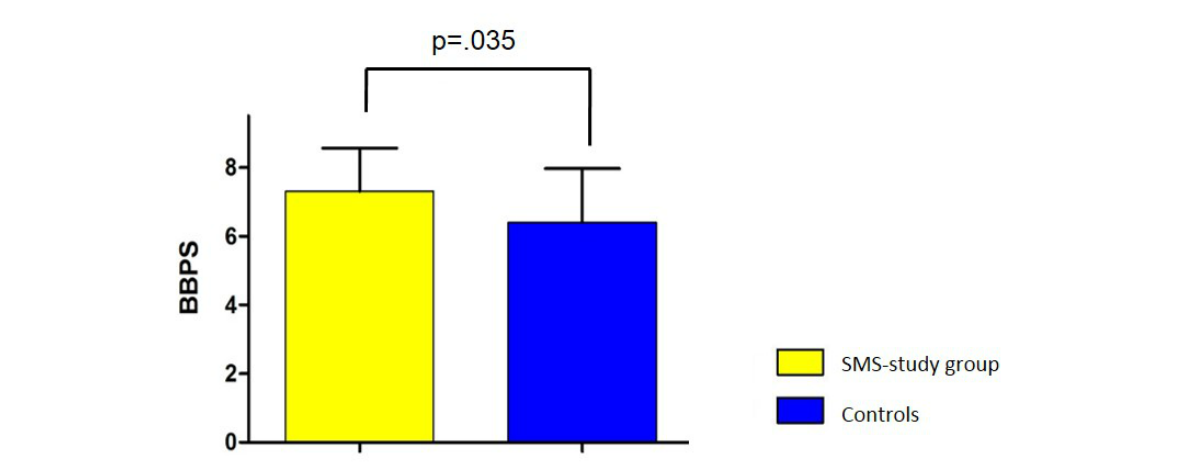
Figure 2. Average Boston Bowel Preparation Scale (BBPS) score in the short message service (SMS) study group was significantly higher in comparison with the control group (7.3 vs 6.4, P =.035). BBPS: 0, minimum to 9,